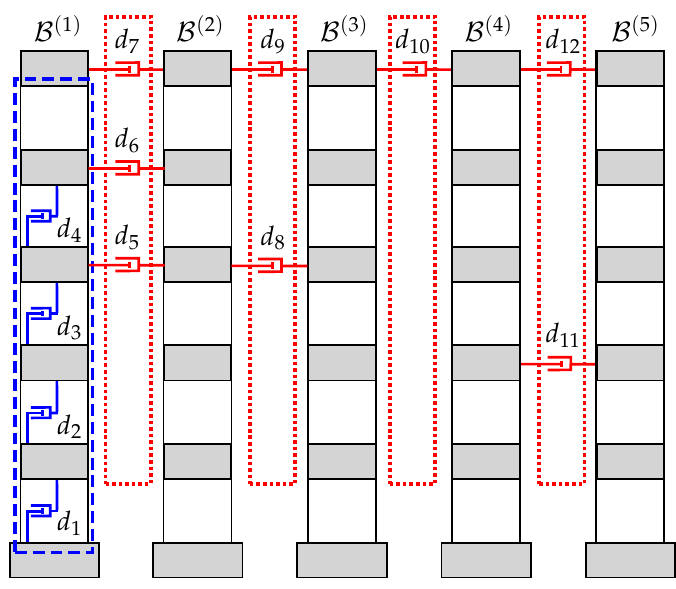
Figure 7. Damping configuration DC3. Full-linked DDS with a single actuated building, ˆ n = 4 interstory dampers and ˜ n = 8 interbuilding